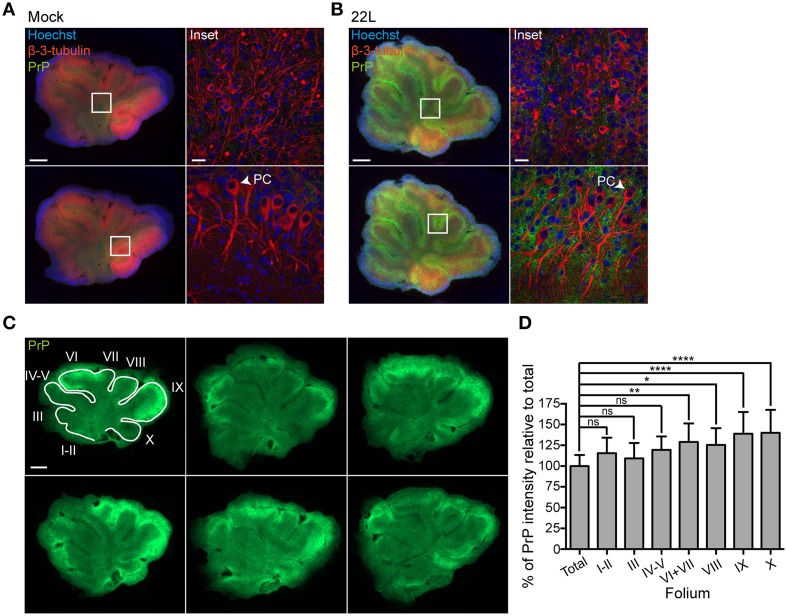
PrPd levels in molecular and Purkinje cell layers. (A,B) Cerebellar slices exposed to Mock brain homogenate or infected with 22L prions and cultured for 5.5 weeks were stained for PrPd (green) following antigen denaturation. PAb against β-3-tubulin (red) was used to label neurons, nuclei were counterstained with Hoechst. Samples were analyzed by epifluorescence microscopy using the tile scanning function (left panels, scale bar: 500 μm). Insets of the granular layer including the white matter (upper panels) and the molecular layer including the Purkinje cell layer (PC) (lower panels) were analyzed by confocal microscopy (right panels, scale bar: 20 μm). (C) Epifluorescence images of cerebellar slices 9 weeks p.i. stained for PrPd (green) following antigen denaturation. Scale bar: 500 μm. (D) Cerebellar folia I-X (from anterior to posterior) were manually demarcated and the PrP intensity per folium was quantified relative to the PrP intensity of the whole slice set to 100% (total). Bars represent mean values ±SD of 14 slices. Statistical analysis was performed using One-way ANOVA with Dunnett's multiple comparisons test. Asterisks indicate significant changes (****p < 0.0001; **p < 0.01; *p < 0.05; ns, not significant).